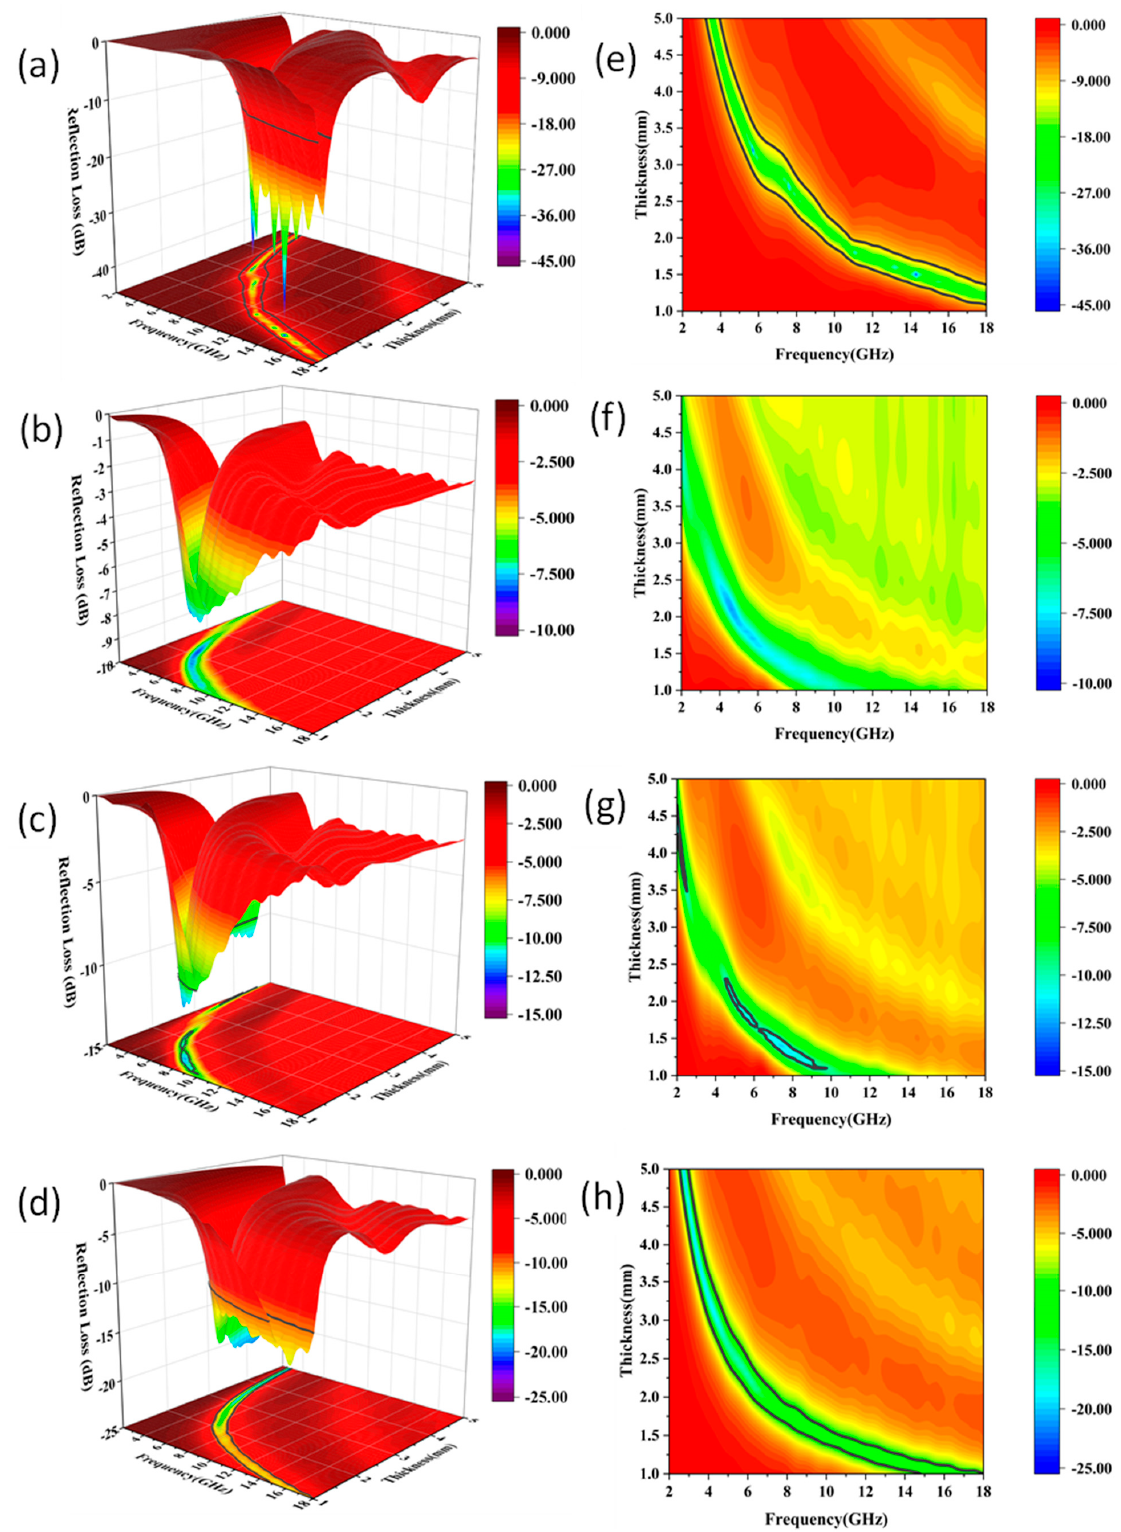
Figure 9. Three-dimensional and contour plots of the RL values of CoFe 2 O 4 /SWCNTs composites with different cobalt salt contents: ( a, e ) Co-1, ( b, f ) Co-2, ( c, g ) Co-3, and ( d, h ) Co-4.